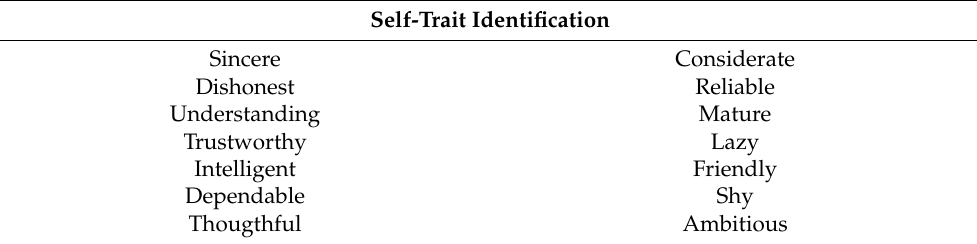
Table 1. Traits used in self-trait